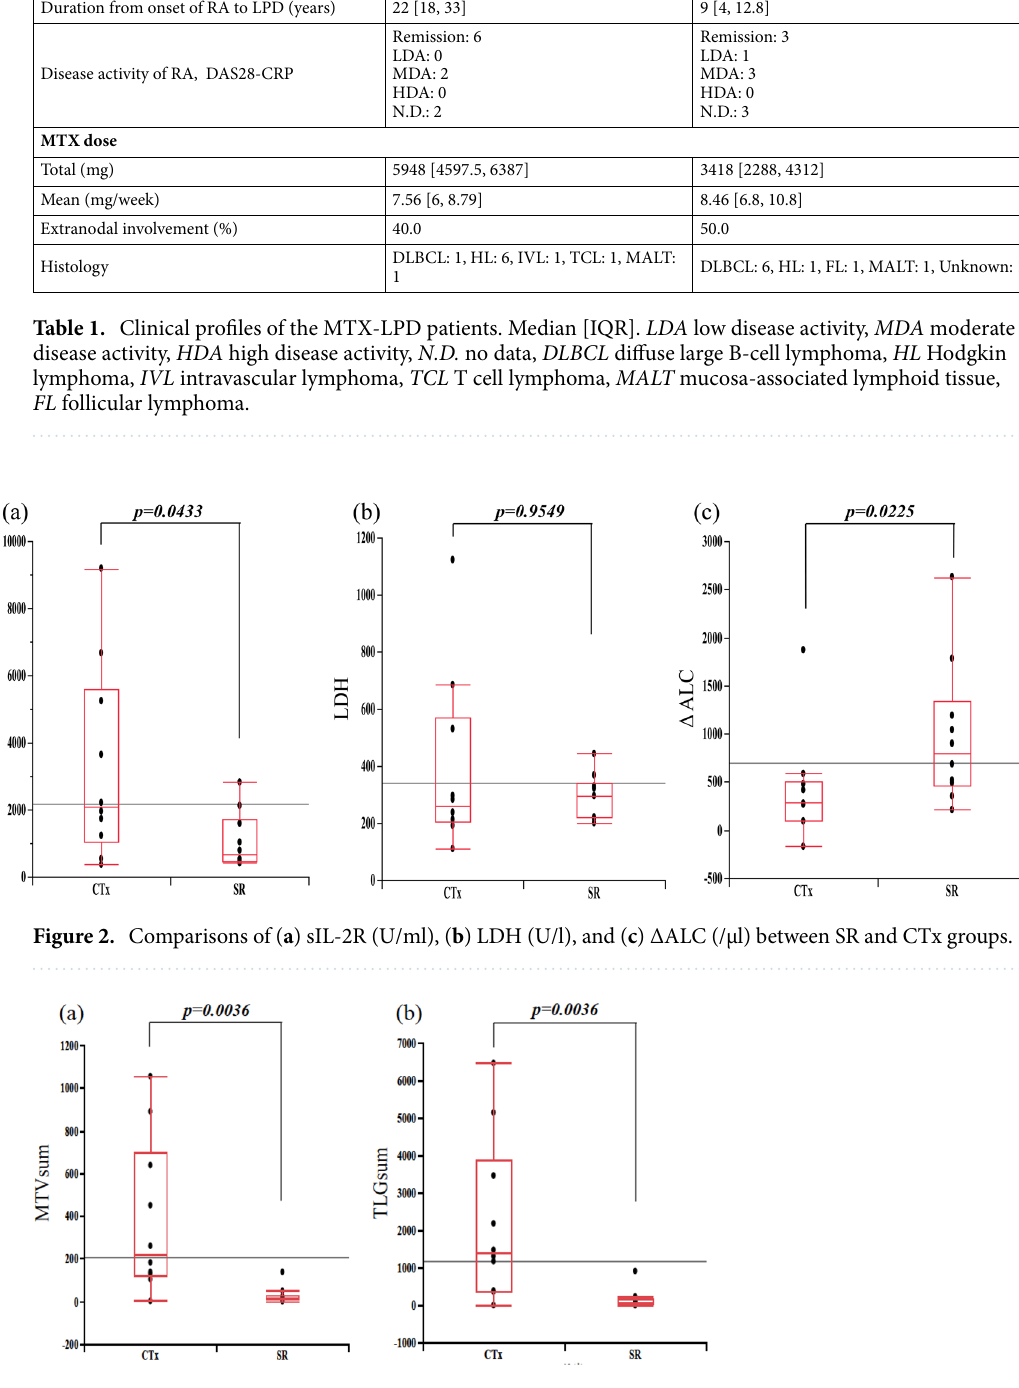
Figure 3. Comparisons of ( a ) MTVsum (ml) and ( b ) TLGsum between SR and CTx